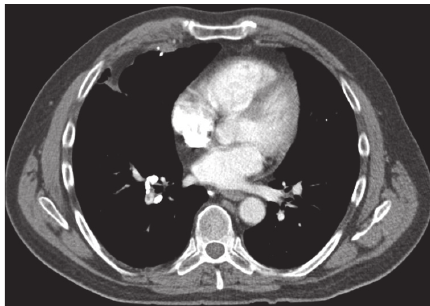
Figure 2: Computed tomography of the chest depicting filling defects in the pulmonary arterial vasculature secondary to pul- monary embolism.